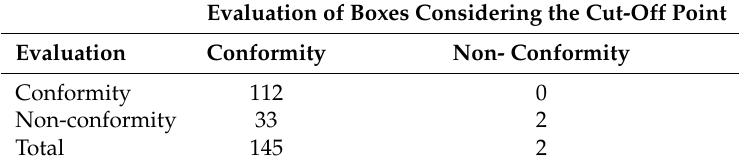
Table 4. Compliance results in the pilot sample, developed by SERNAPESCA during August 2018, in Melinka, Quellón and Castro ports.